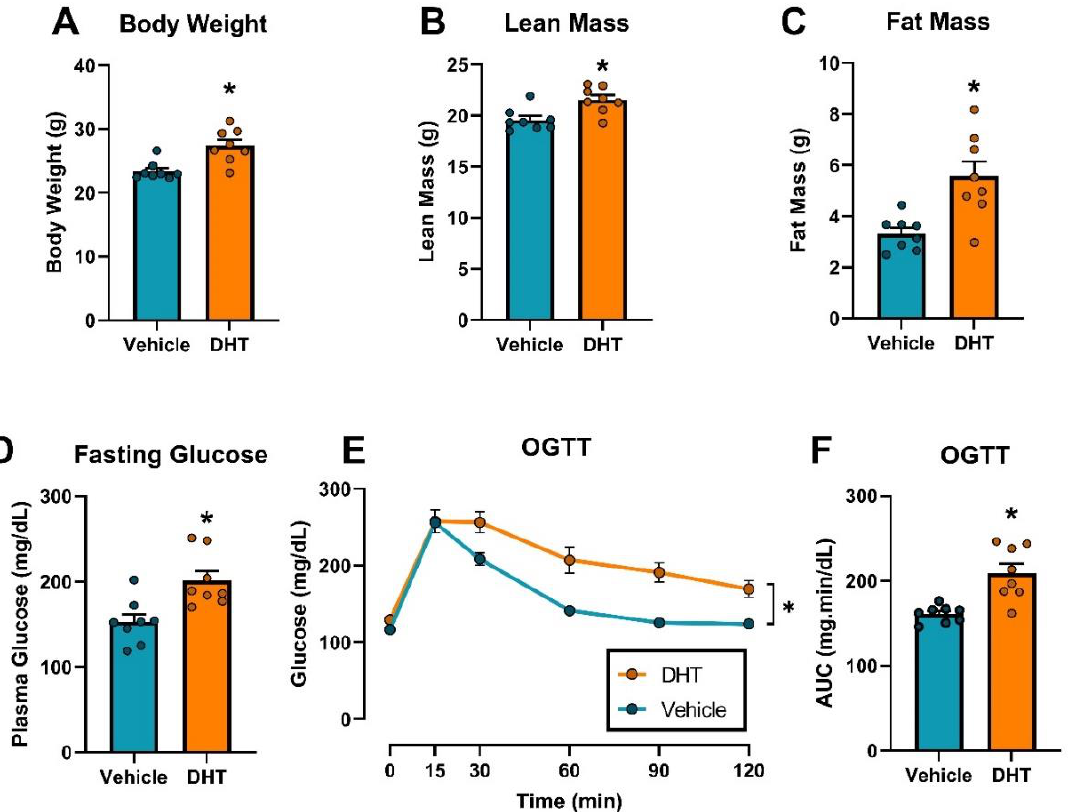
Figure 1. Effect of DHT on body weight and composition, and glucose homeostasis. ( A ) Body weight ( n = 8/group). ( B ) Fat mass by EchoMRI ( n = 8/group). ( C ) Lean mass by EchoMRI ( n = 8/group). ( D ) Fasting glucose ( n = 8/group). ( E ) Time-course of Oral glucose tolerance test (OGTT) ( n = 8/group). ( F ) Area under the curve (AUC) from OGTT ( n = 8/group). Data analyzed by t -test. *: p <